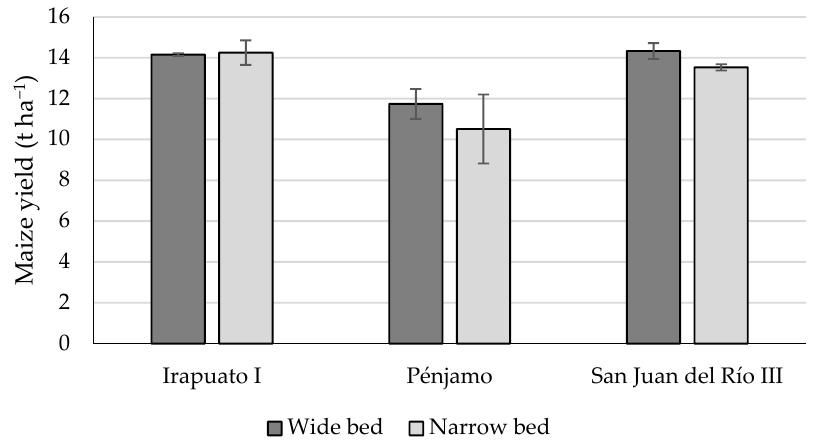
Figure 7. Yield of maize with planting in wide and narrow beds under irrigated conditions at three sites in central Mexico. Average yield during the duration of the study; error bars represent the standard deviation of the mean.